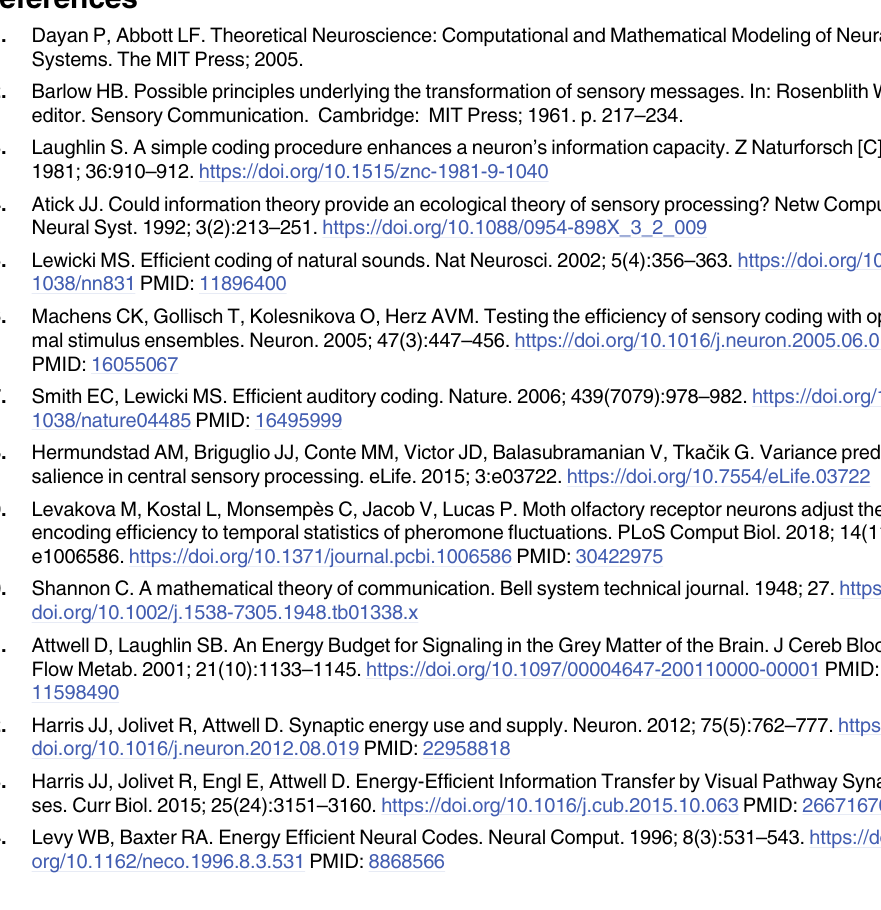
S1 Fig. Stimulus-response relationships with identical scales. Same as Fig 2, but the scales are same for all the neurons and inhibition scaling factors B . Each row corresponds to a differ- ent inhibition regime. The ratio of inhibitory to excitatory conductance as a function of stimu- lus intensity is displayed in the leftmost column. The time window Δ was in this case chosen as 500 ms. The x -axis is logarithm of the rate of bombardment by excitatory synapses (Eq 23). The y -axis shows the post-synaptic firing rate (Eq 21).